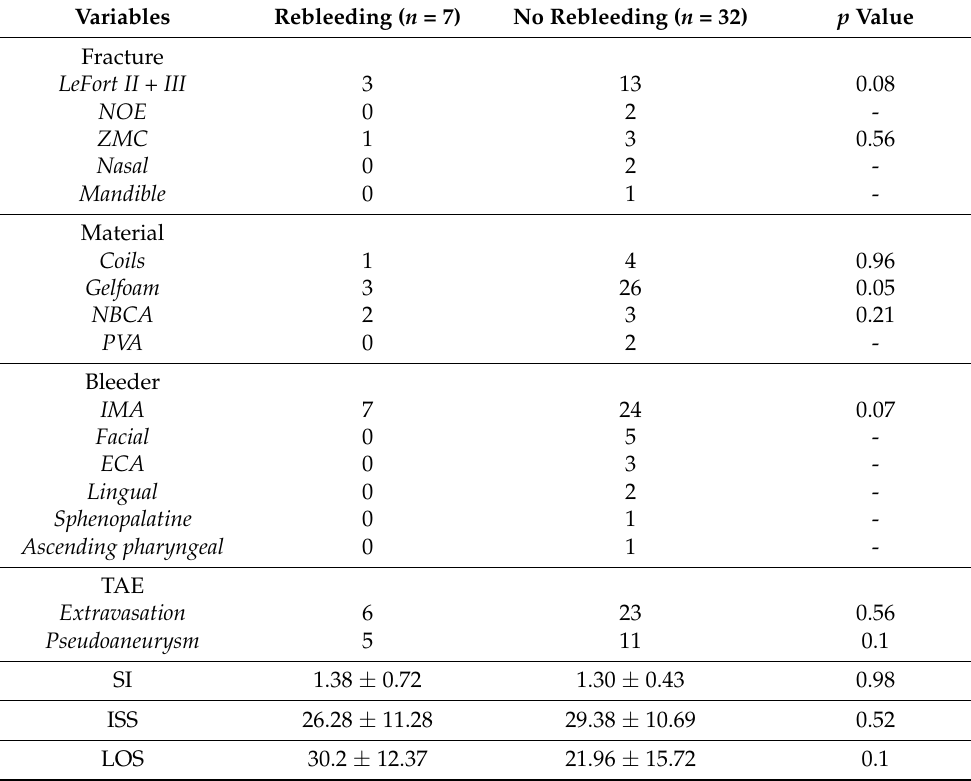
Table 2. Demographics of patients with traumatic life-threatening oronasal bleeding (ONB) requiring TAE with rebleeding and without